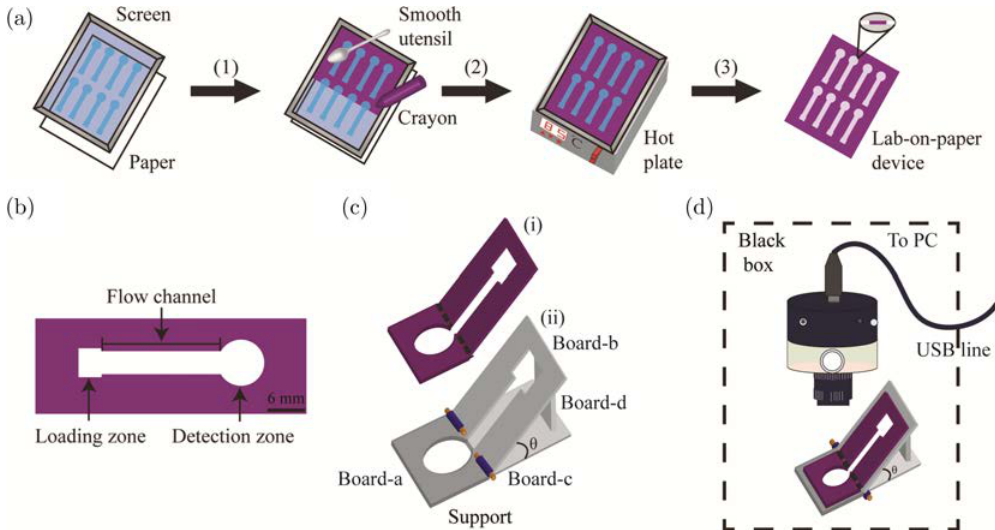
Fig. 1. Schematics of fabrication and assembly of GCF-CL paper-based micro°uidic devices. (a) Illustration of wax screen-printing fabrication for paper-based micro°uidic devices, in which the screen placed on the paper is rubbed with crayon and smooth utensil (1), and then the paper is placed on a hot plate together with the screen (2), followed by separation from each other to form a patterned paper device (3). (b) The layout of the unfolded GCF-CL paper-based micro°uidic device. (c) Diagram of the paper-based micro°uidic device folded into a desired shape along a fold line (i) and a folder-type plastic support with an adequate incision as indicated in white (ii). (d) Schematic of the assembled paper device placed under the CCD in the black box for GCF-CL